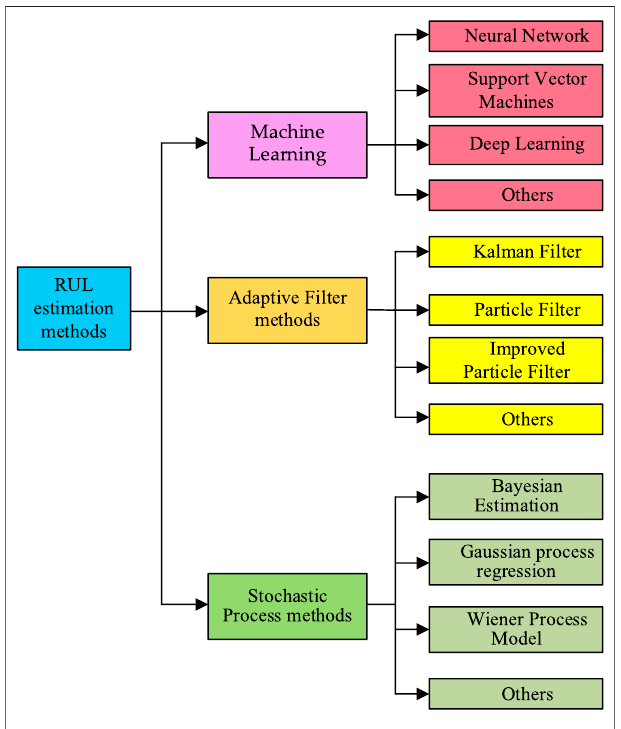
FIGURE 1 | The main RUL prognosis